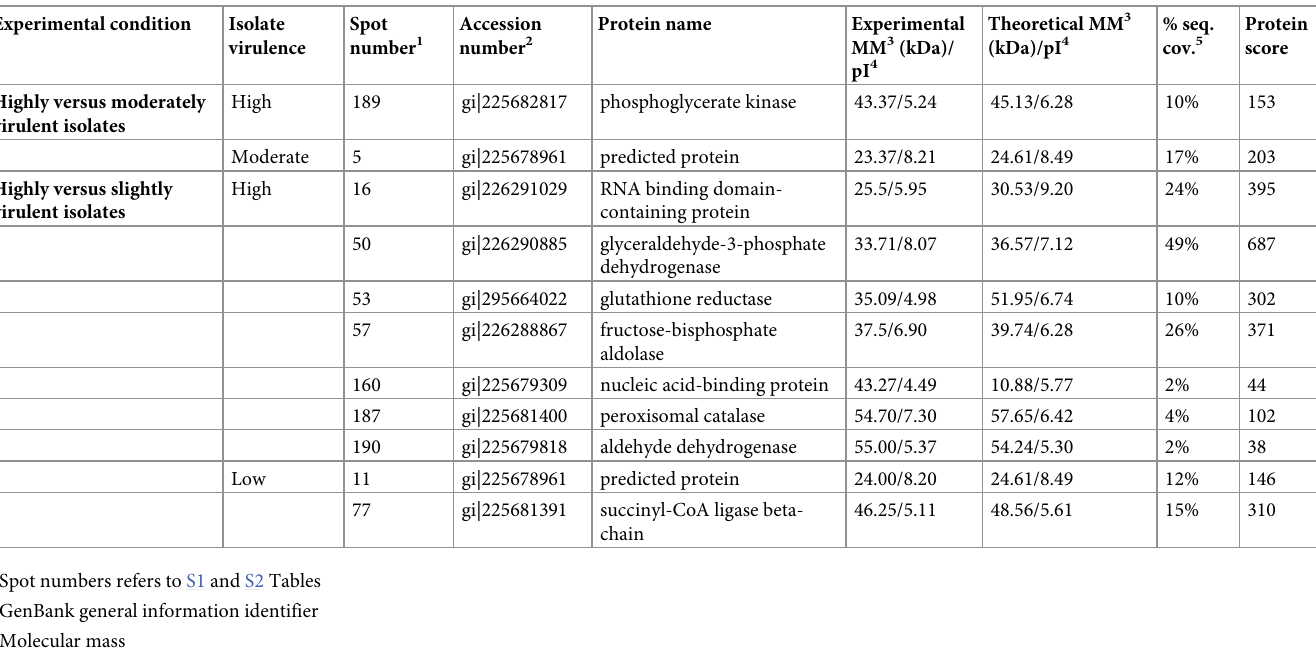
Table 3. Identification of protein spots from 2D electrophoresis gels from P . brasiliensis complex isolates by LC-MS/MS. Experimental condition